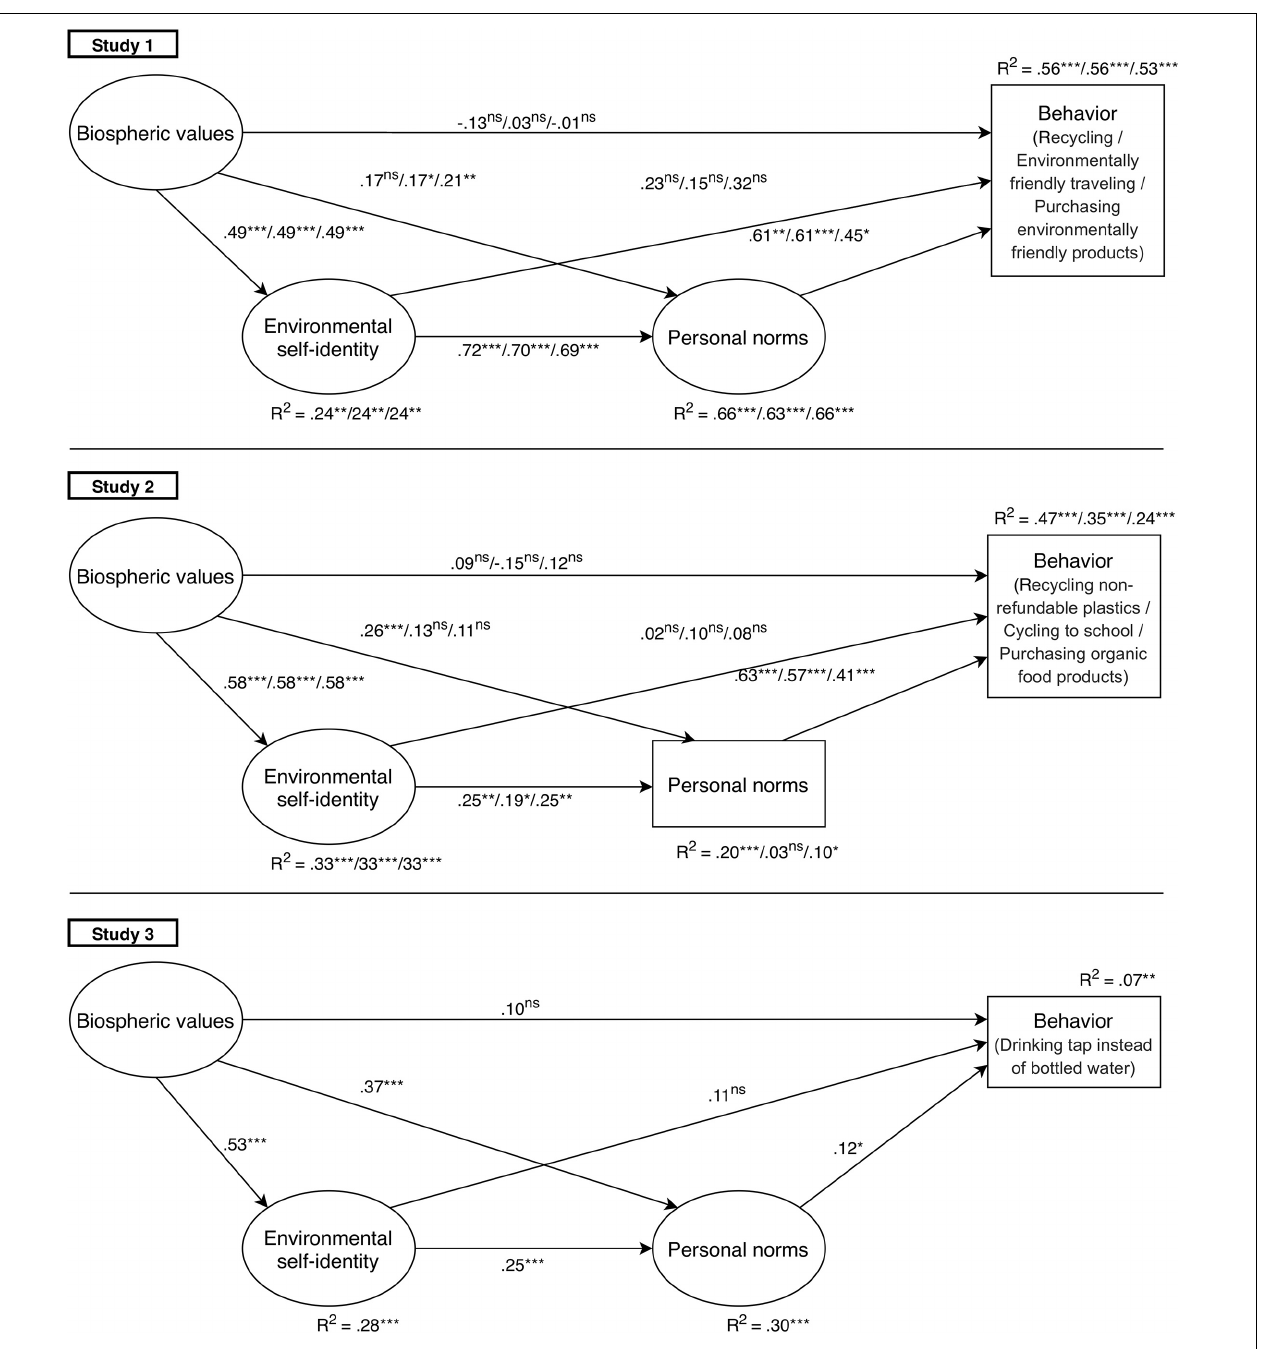
FIGURE 3 | Standardized regression coefficients of the direct model paths for environmental considerations and pro-environmental behaviors in three studies in adolescents’ sample. Note. ns, non-significant; * p < 0.05, ** p < 0.01, *** p < 0.001. In Study 1 and Study 2 each coefficient represents three behaviors,